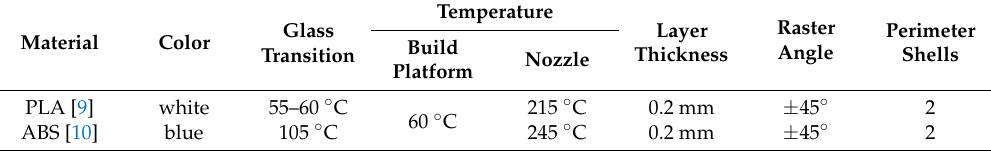
Table 2. Selective material properties and utilized process parameters for the manufacturing of the multi-material test specimens separated between acrylonitrile butadiene styrene (ABS) and polylactic acid (PLA)